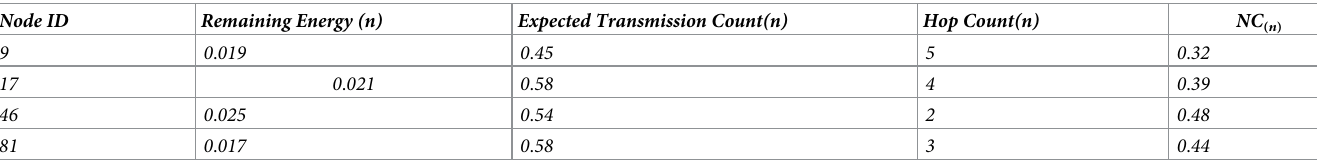
Table 1. Parameters for each sensor